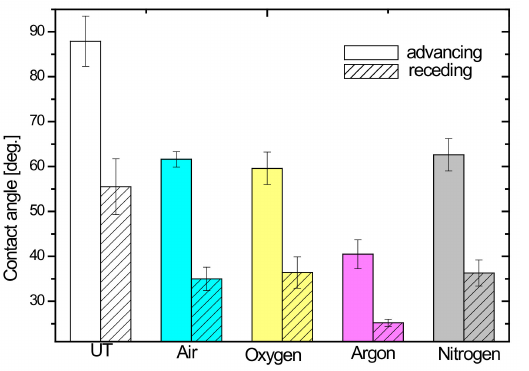
Figure 2. Advancing and receding contact angles of water measured on the unmodified and modified plasma.